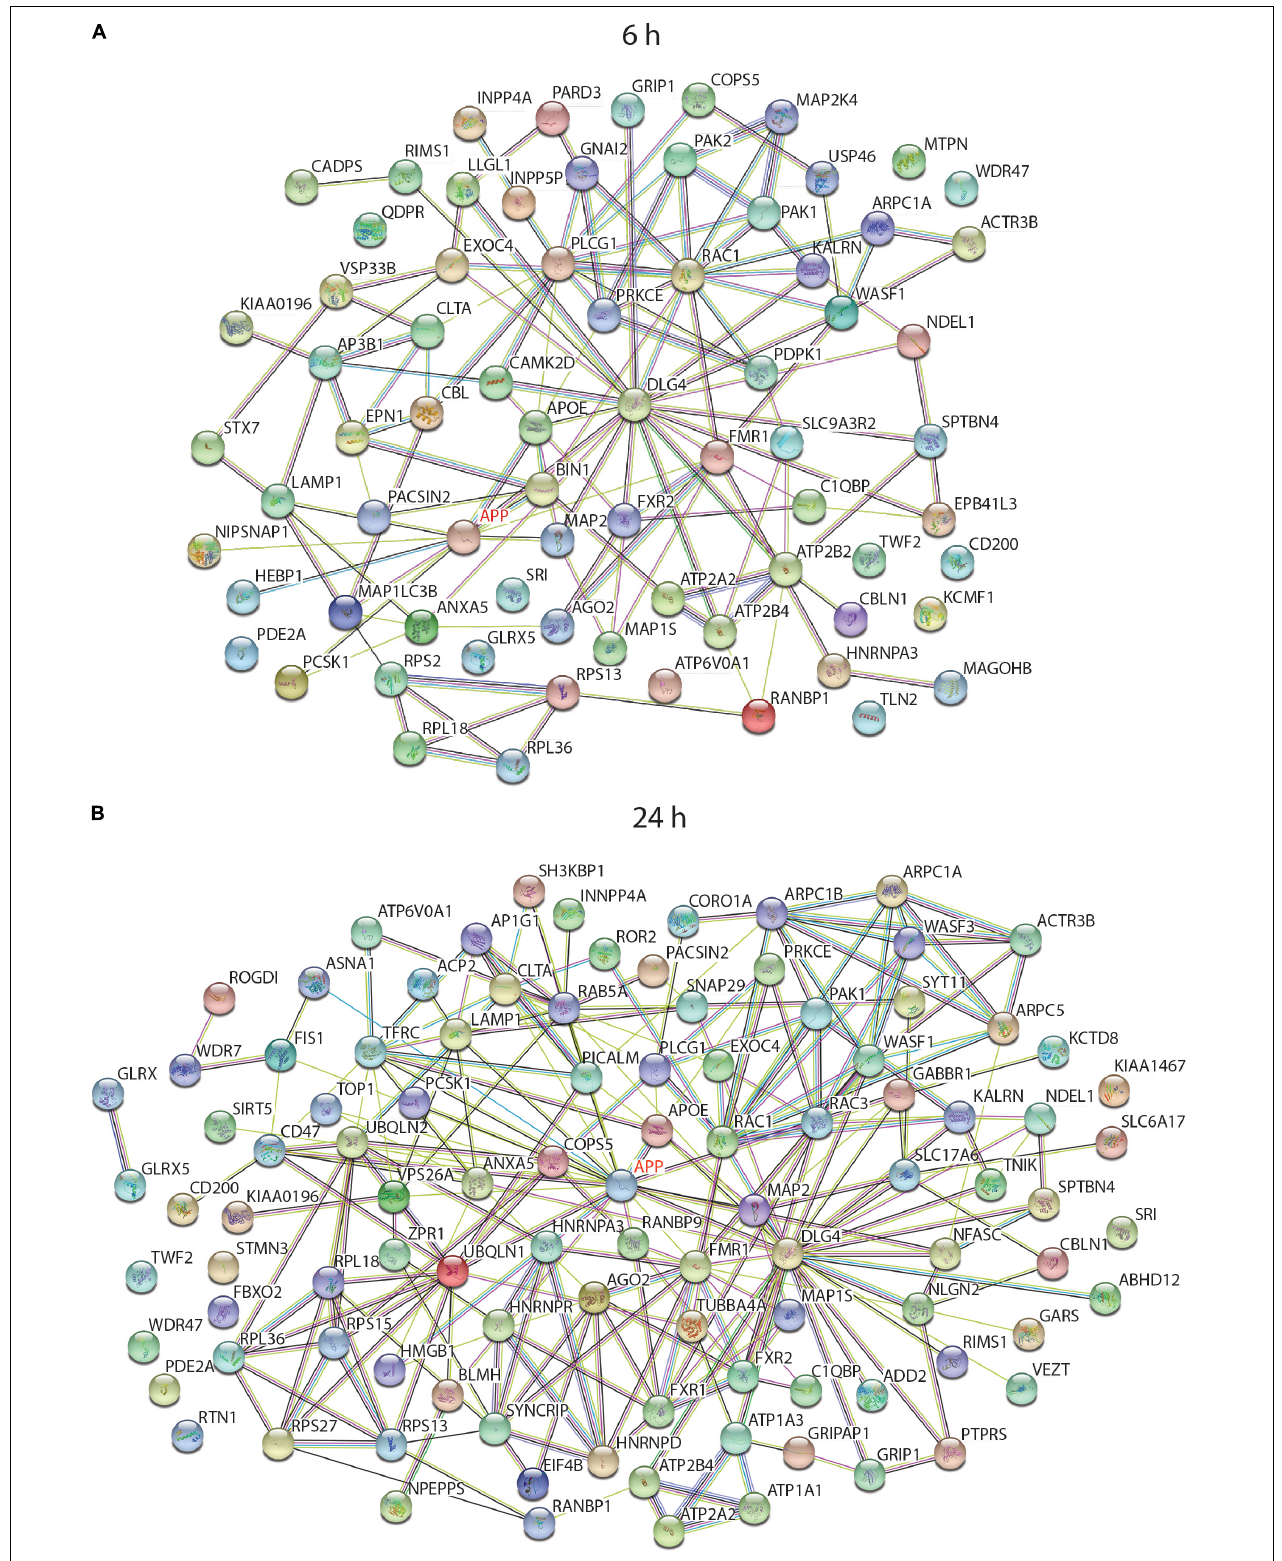
FIGURE 6 | String analysis of functional interactions of differentially regulated proteins after incubation of neurons with sAPP α . Diagram shows the significantly differentially regulated proteins, which were linked to cellular component GO terms with a neural functions and/or had a connection to APP, and their relationship to others in the 6 h (A) and 24 h (B) data set when searched against the human protein database (log2 (FC) -/+ 0.58, p ≤ 0.01).